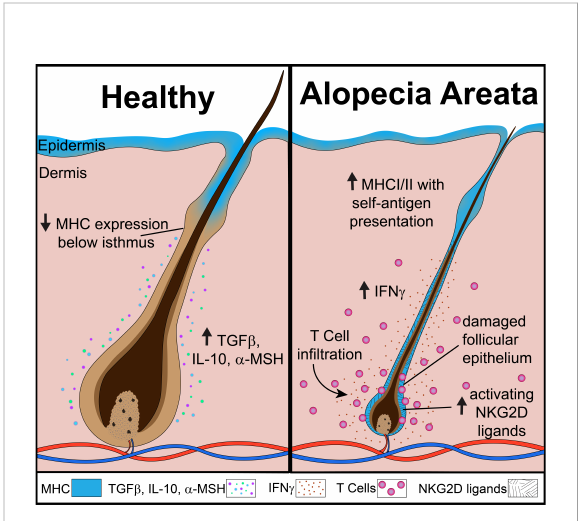
FIGURE 1 The collapse of immune privilege in the anagen hair follicle during alopecia